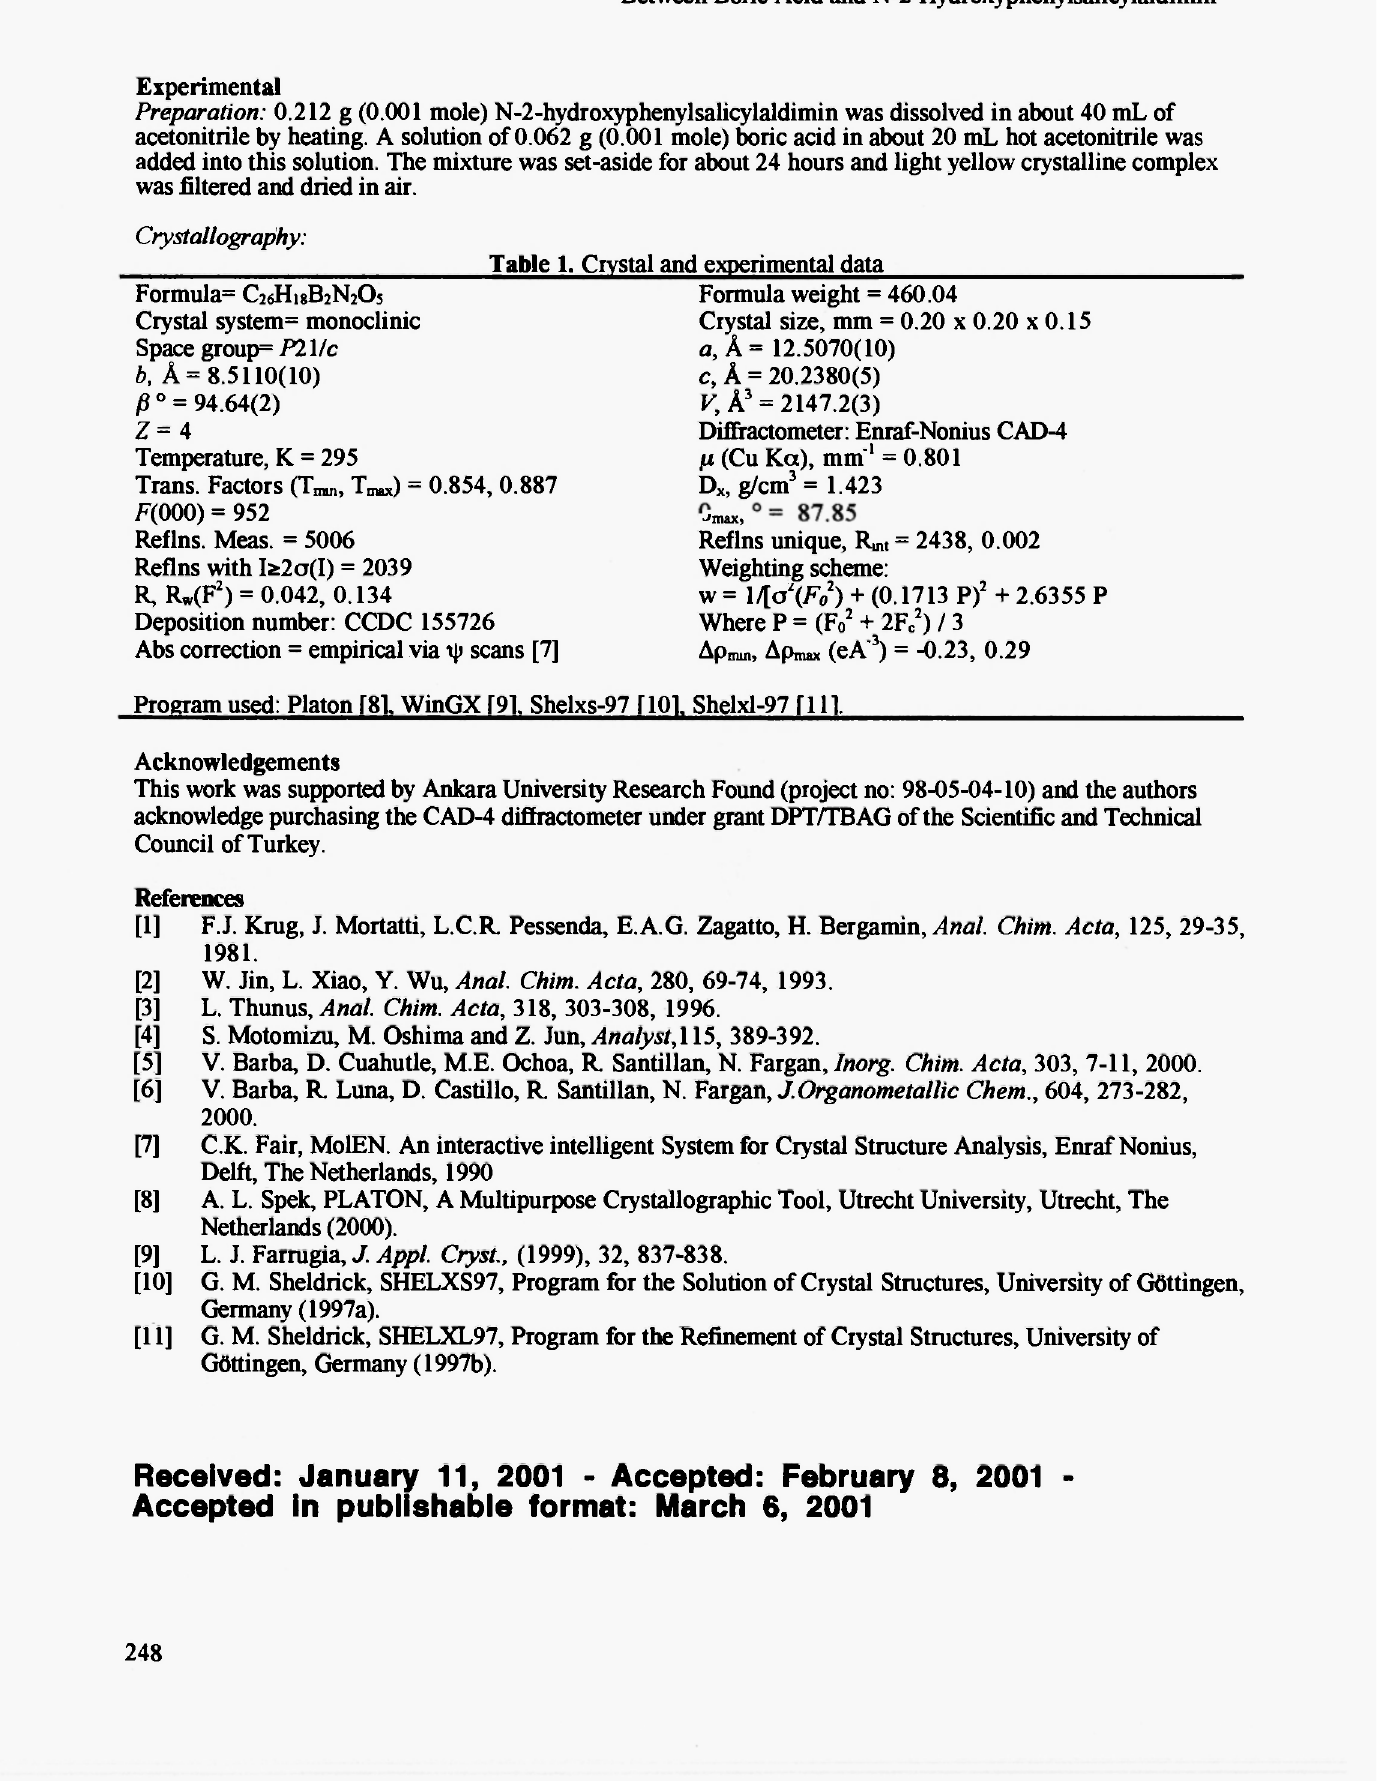
Table 1. Crystal and experimental